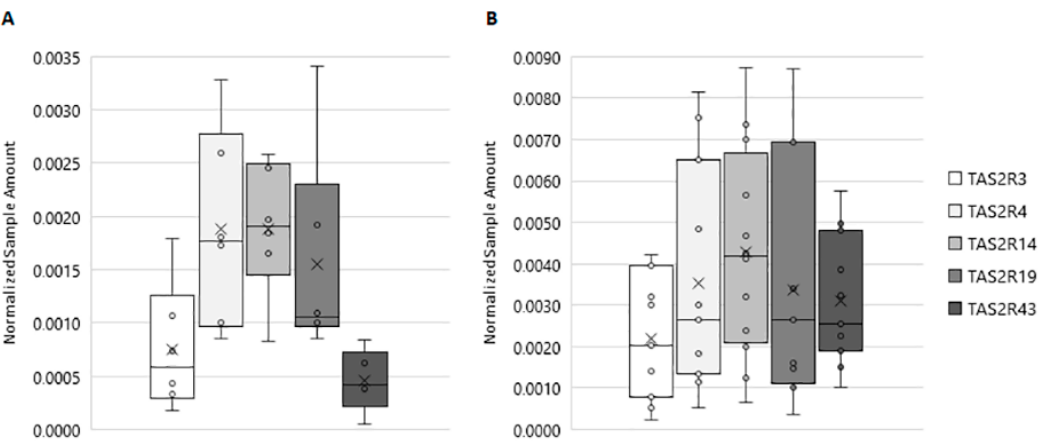
Figure 1. Expression of TAS2Rs in human testis and in ejaculated sperm. ( A ) TAS2Rs normalized sample amount in human testis. ( B ) TAS2Rs normalized sample amount in human sperm. Graphical diagrams are plotted as box–whisker plots, where boxes show the interquartile range with median and mean values, and whiskers represent min and max confidence intervals. Number of analyzed samples: testis: 6, sperm: 15.